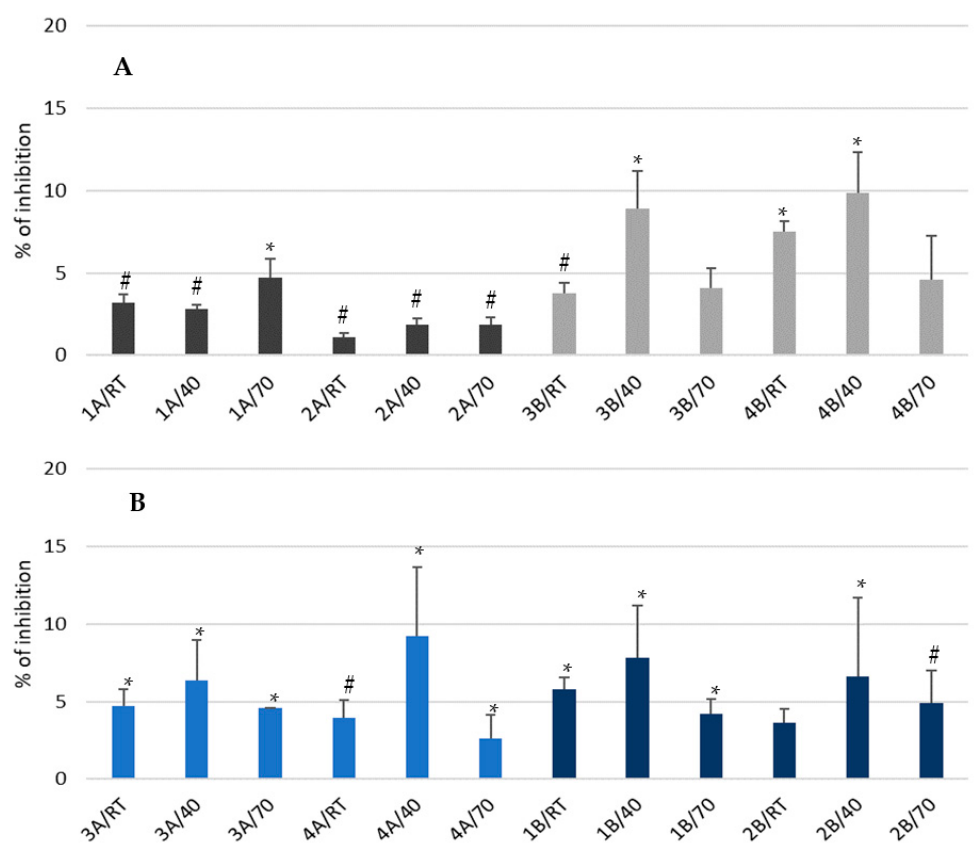
Figure 3. Inhibition of DPPH radical (%) in the presence of extracts obtained sequentially at different temperatures and using ethanol ( A ) or water ( B ) as a solvent. Values are presented as mean ± SD ( n = 4). If the values are not significantly different at 0.05 significance compared to the ones obtained from the highest value sample (4B/40), they are signaled with *; if the values are not significantly different at 0.05 significance compared to the ones obtained from the lowest value sample 2A/RT, they are signaled with #. Darker colored bars refer to the first and second extractions, with the lighter colored bars referring to the third and fourth extractions.